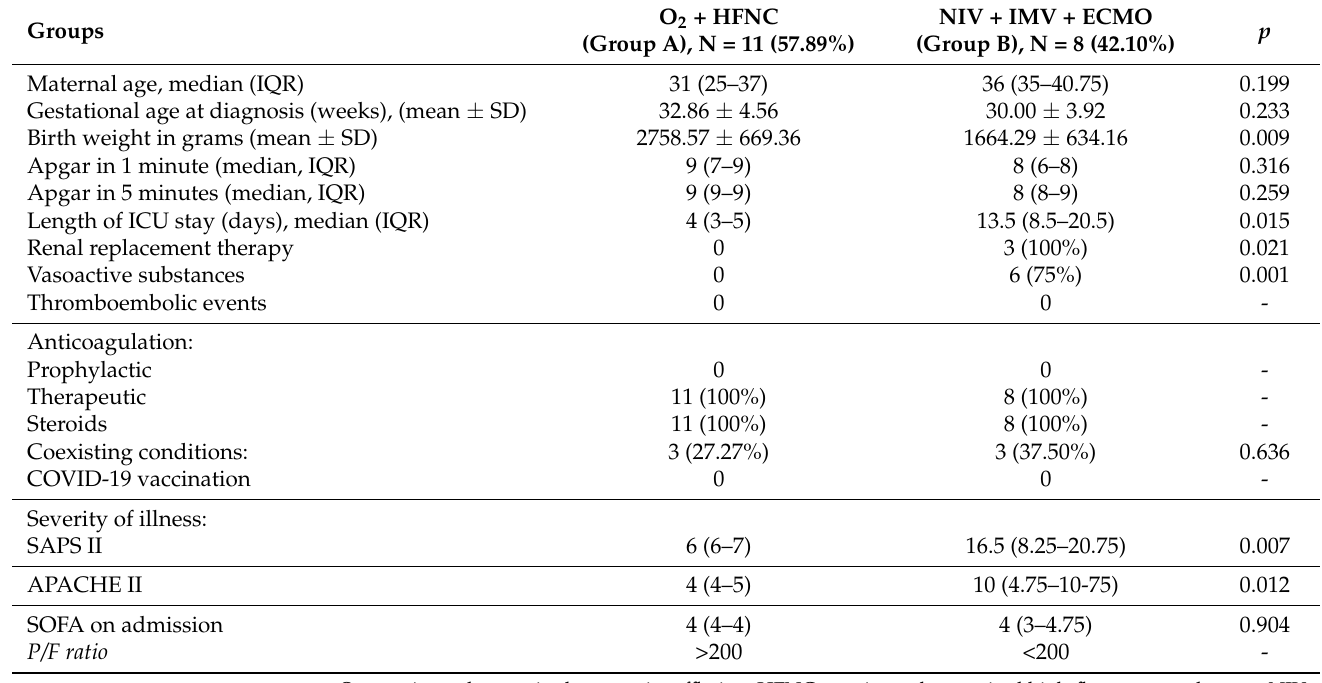
Table 2. Demographic and clinical characteristics of all treated pregnant/postpartum women and basic characteristics of